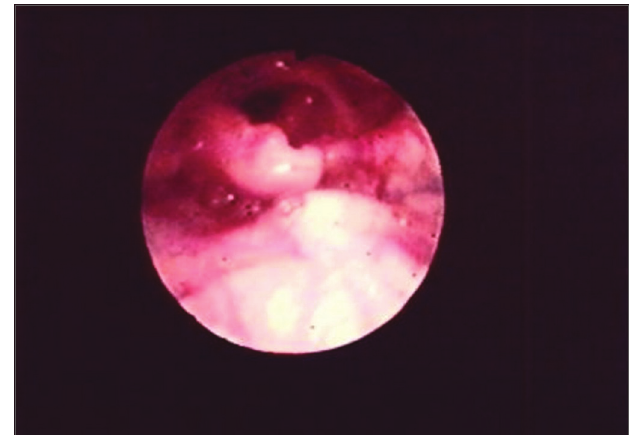
Figura 5. Amputação parcial de